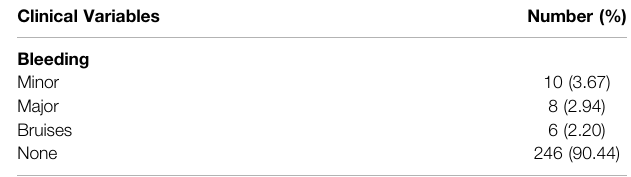
TABLE 4 | Complication of